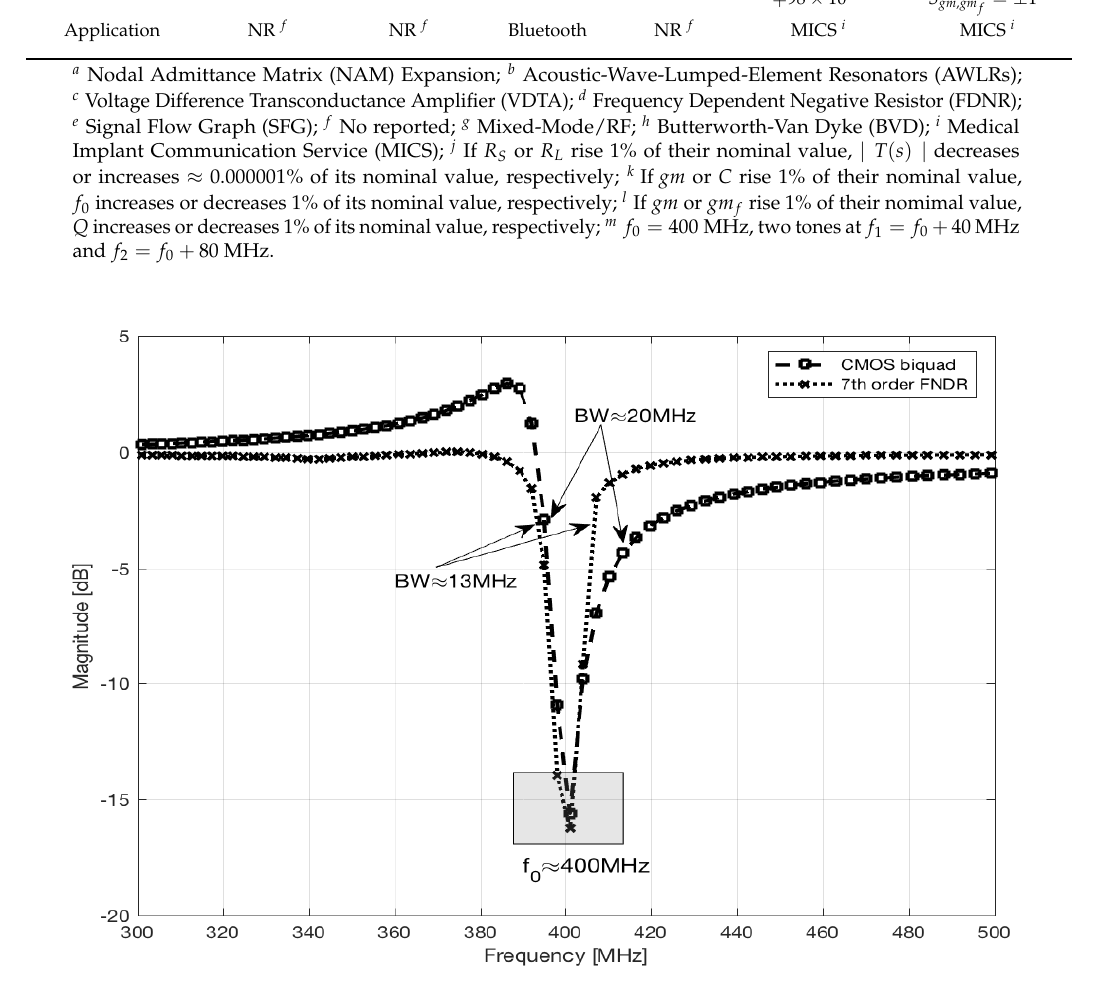
Figure 10. Frequency response of both the suggested SFG CMOS biquad and the 7th order